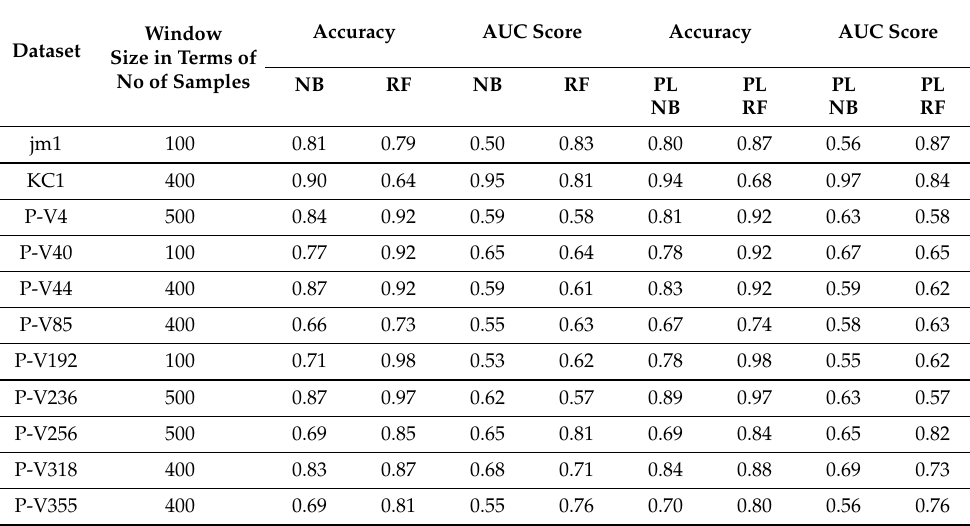
Table 6. Accuracy and ROC-AUC